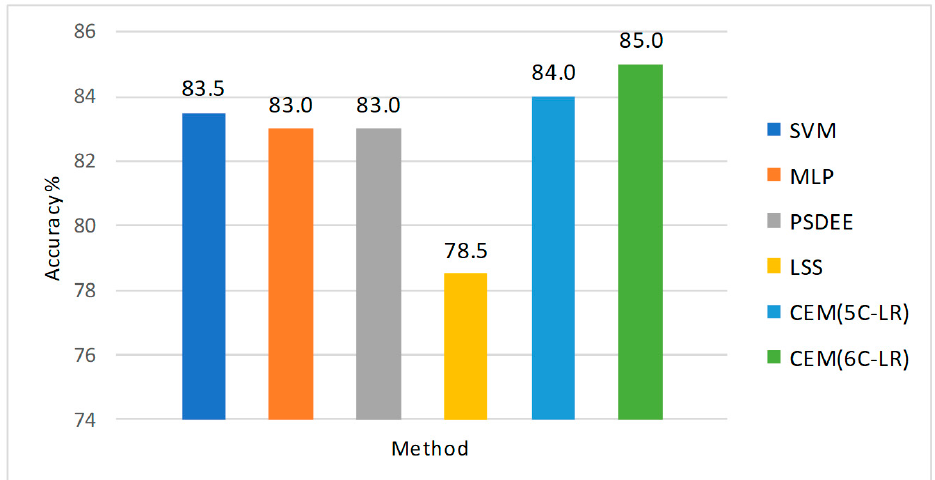
Figure 7. Results experimented on corpus Electronics.